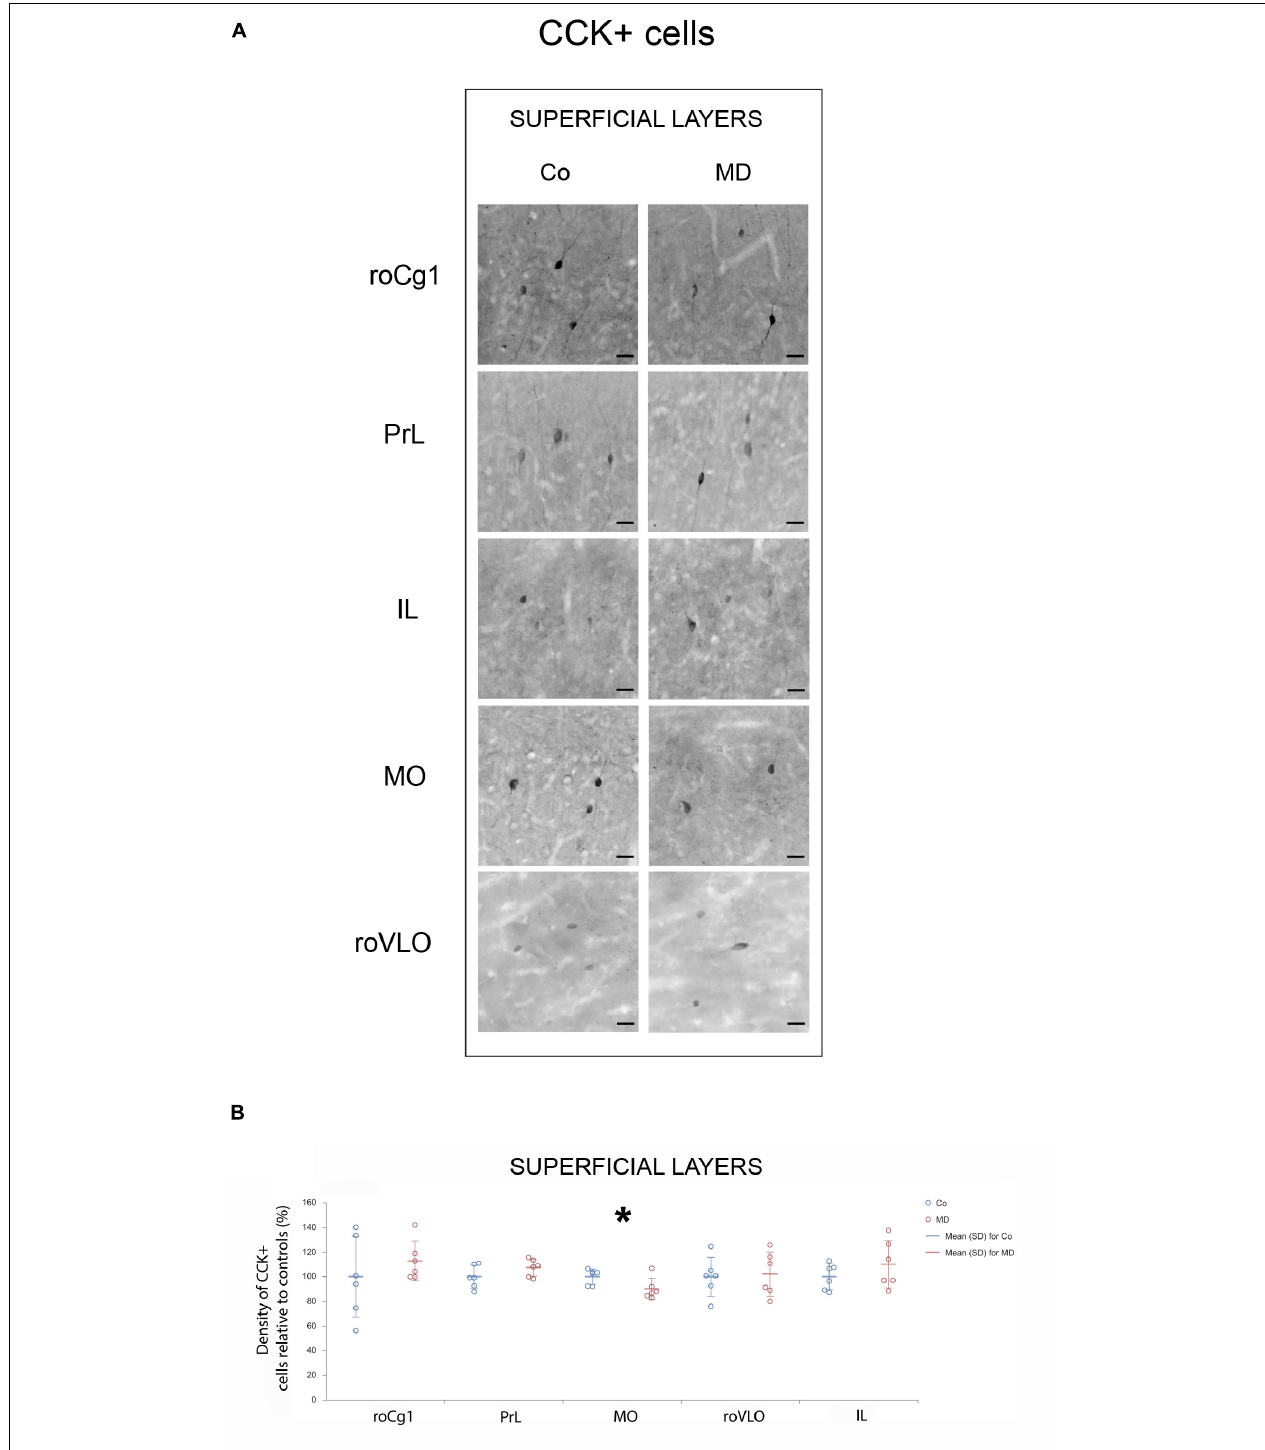
FIGURE 4 | Effects of MD on CCK + cell density in PFC on PND60. Representative photomicrographs of CCK + immunohistochemistry (A) . Dot plot graphs in (B) representing quantification of the results as means ± SD (horizontal bars) and observed values (dots), n = 6 per group in superficial layers of the respective PFC area. MD rats had lower CCK + cell density in the superficial layers of MO (B) . * p < 0.001 Co vs. MD. roCg1 rostral part of area 1 of cingulate cortex, Co control, IL infralimbic cortex, MD maternally deprived rats, MO medial orbital cortex, PrL prelimbic cortex, roVLO rostral part of the ventral lateral orbital cortex. Scale bars in (A) correspond to 25 µ